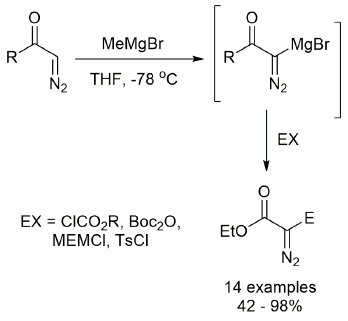
Figure 50 - The C-C coupling of the terminal diazocarbonyl with other